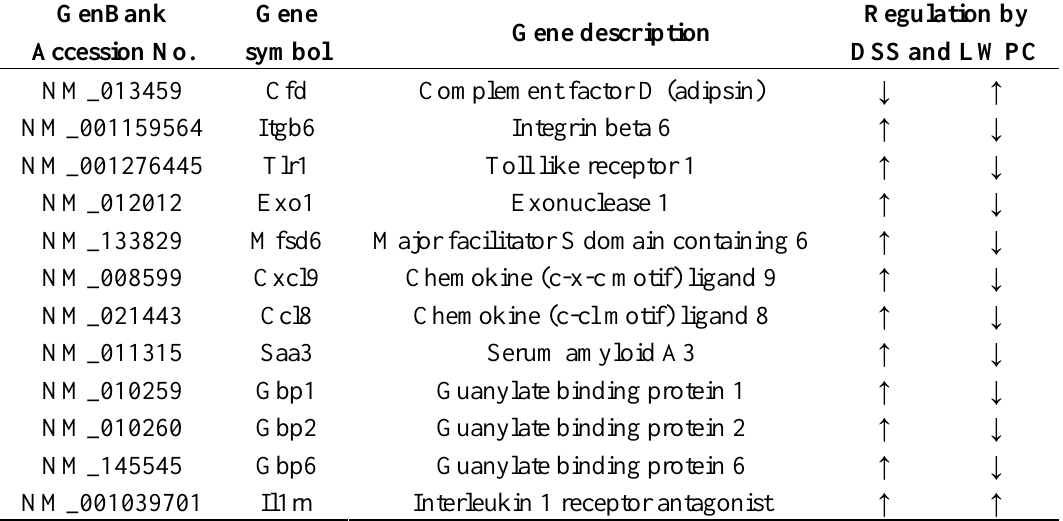
Table 5. The genes in “immune response” (GO:0006955) whose expression was regulated by both DSS and LWPC.